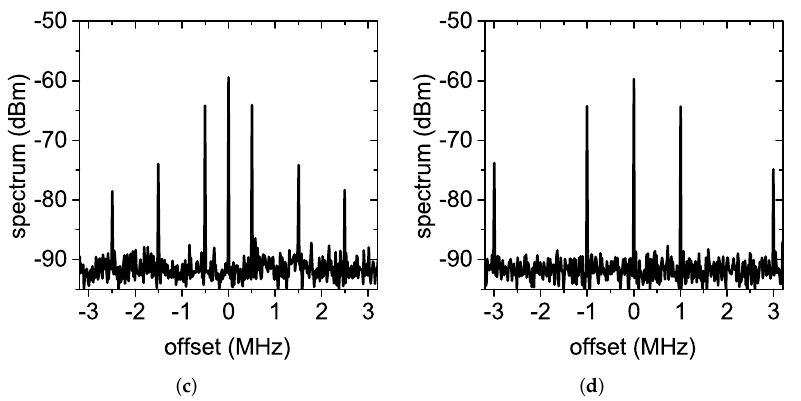
Figure 10. Spectrum received from the complete wireless harmonic transponder for diverse modula- tion frequencies. ( a ) f m = 100 kHz, ( b ) f m = 200 kHz, ( c ) f m = 500 kHz, and ( d ) f m = 1 MHz.